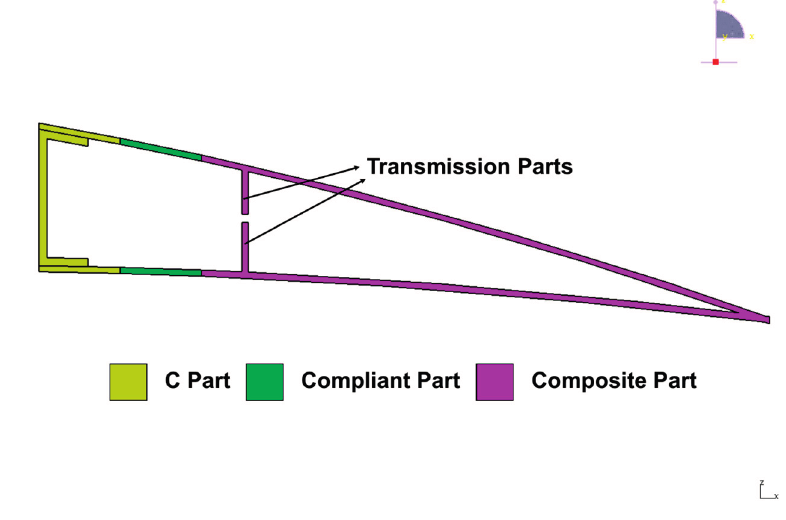
Figure 2. Hybrid trailing edge open cell control surface design.